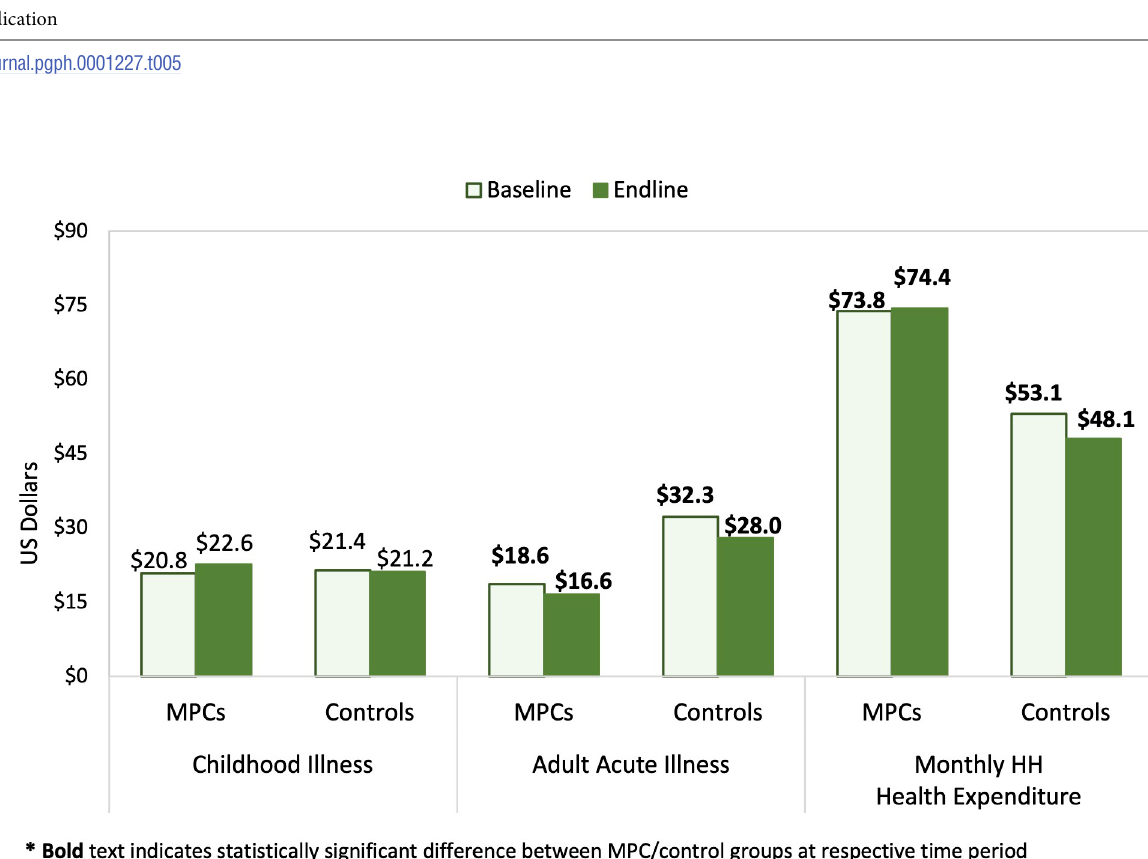
Fig 3. Health expenditures by group (one-year period from baseline to